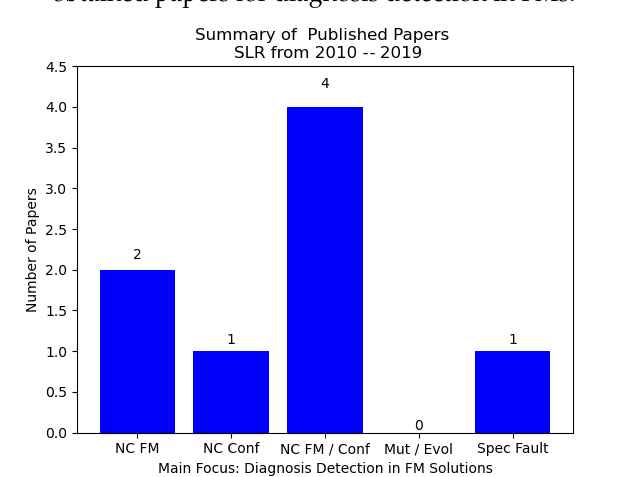
Figure 5. Resume of published papers for diagnosis in FMs from 2010 to August of